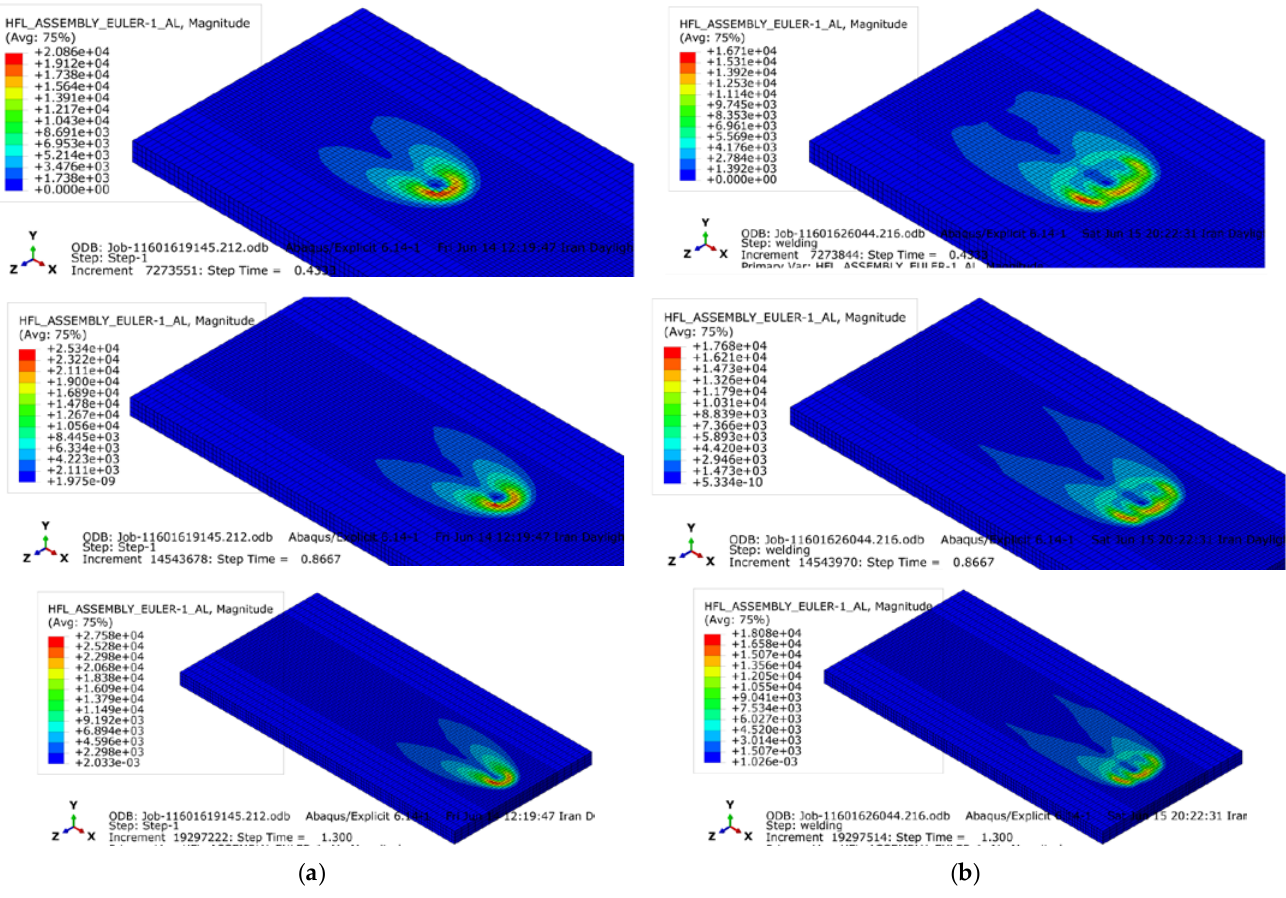
Figure 12. The distribution of the heat flux before ( a ) and after ( b ) applying the tilt angle.